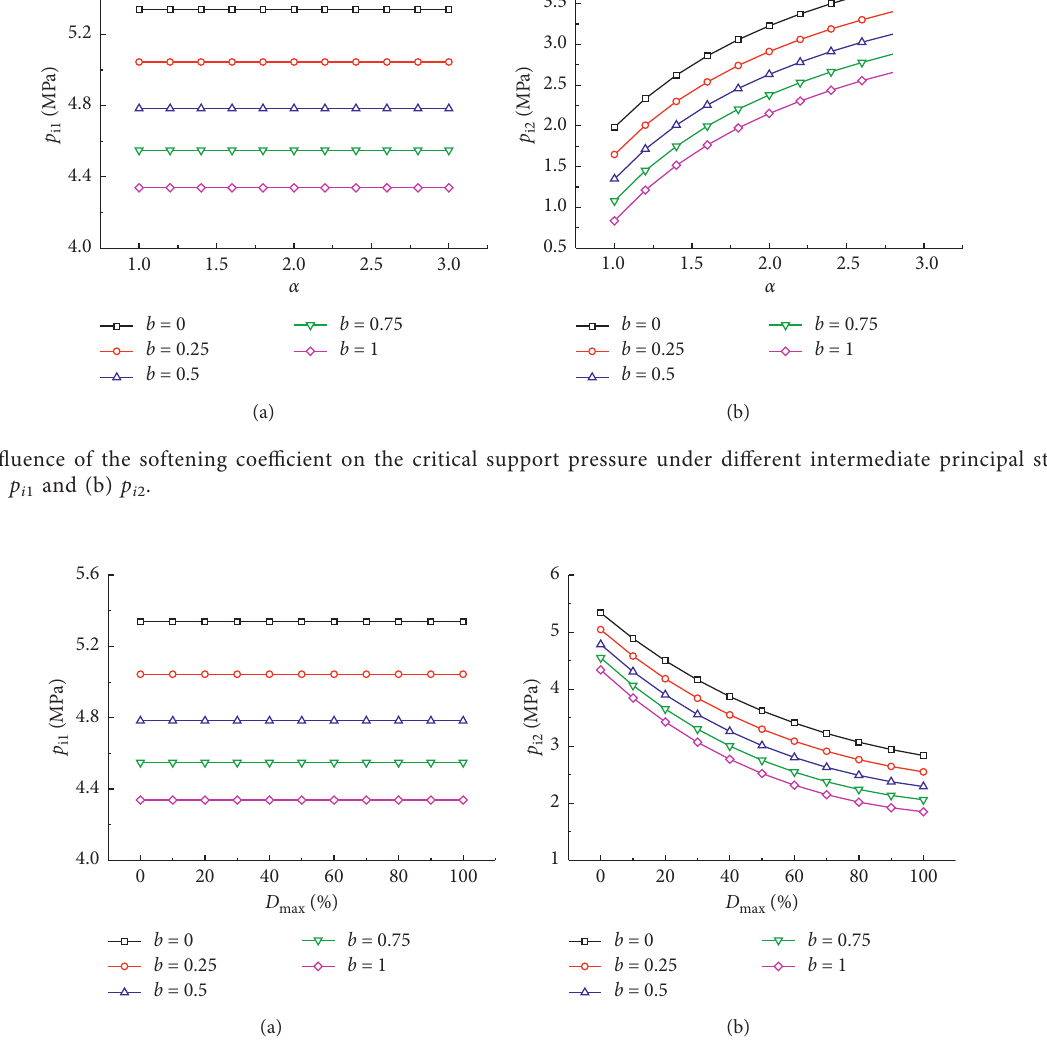
Figure 7: Influence of the maximum damage variable on the critical support pressure under different intermediate principal stress coefficients. (a) p i 1 and (b) p i 2